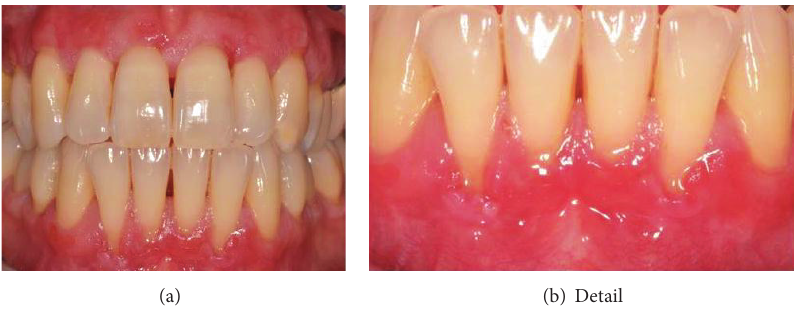
Figure 2: Clinical picture of the inferior frontal areas after periodontal